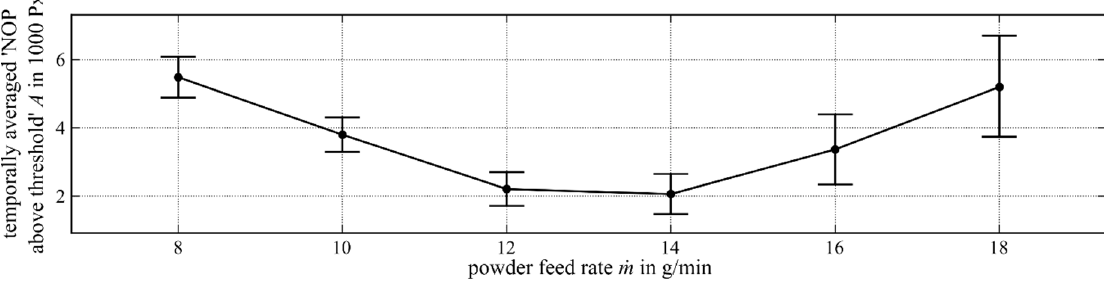
Figure 8. Temporally averaged NOP (intensity threshold 948 digits) over the powder feed rate variation.